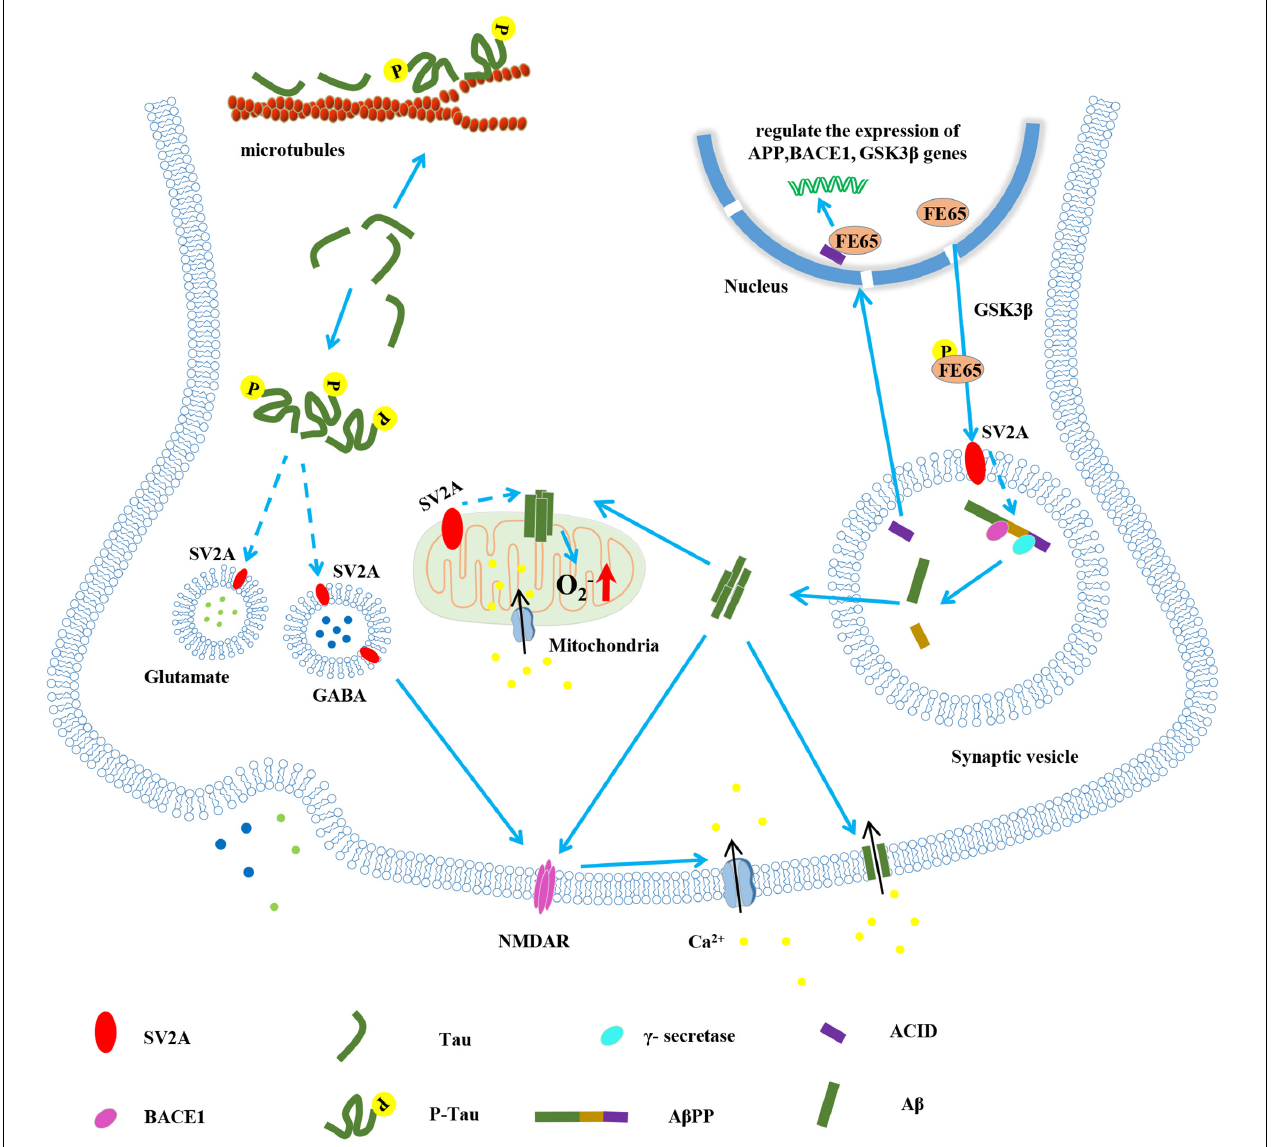
FIGURE 1 | The pathological role of SV2A in the pathogenesis of AD. Known (solid lines) and hypothetical (dotted